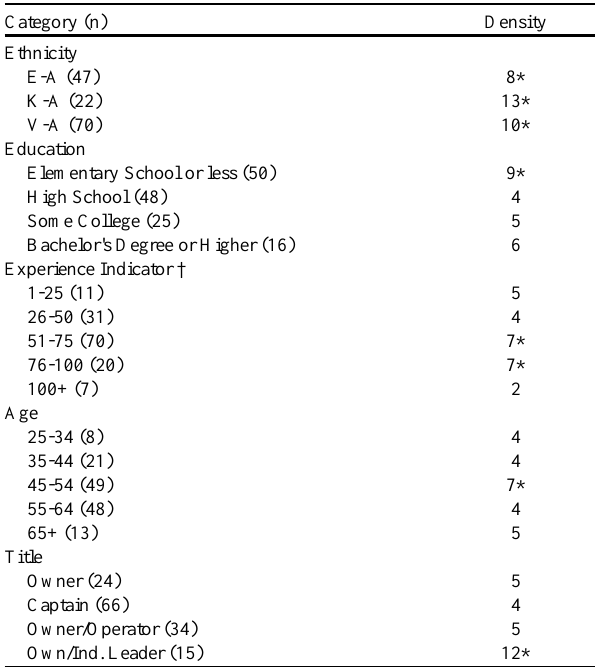
Fig. 3 . Network configuration of all relations identified by Table 2 . Density of ties by individual attribute (ethnicity,